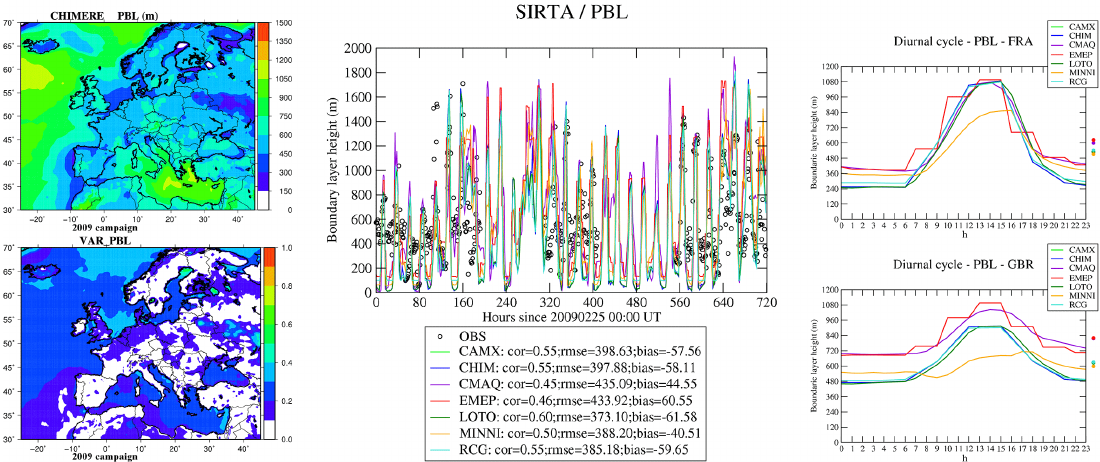
Figure 2. Spatial representations and time variations of the PBL height for the 2009 campaign. Top left panel: mean height of the CHIMERE PBL height issued from ECMWF data. Bottom left panel: mean coefficient of variation for the PBL height. Central panel: hourly variation of the PBL height at the SIRTA station. Top right panel: average diurnal cycle of the PBL height predicted by the models in France. Bottom right panel: average diurnal cycle of the PBL height predicted by the models in Great Britain.